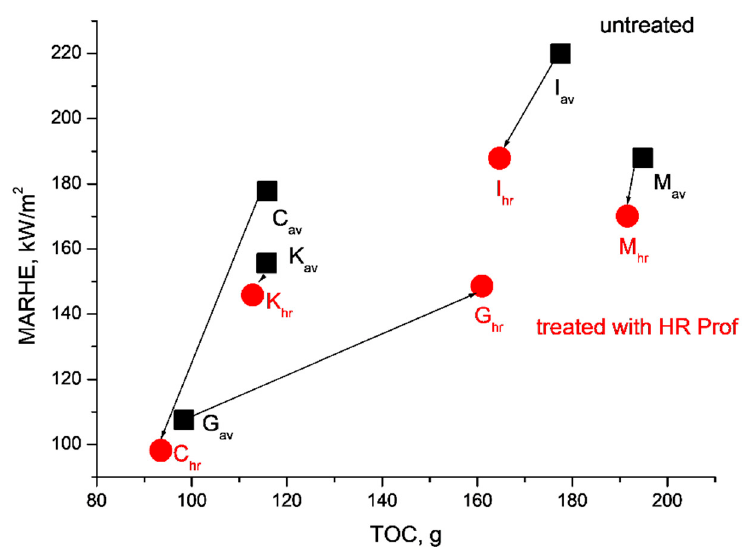
Figure 9. The correlation between MARHE and total oxygen consumed for untreated and treated samples of tropical woods (Table 2). The cone radiancy is 35 kW/m 2